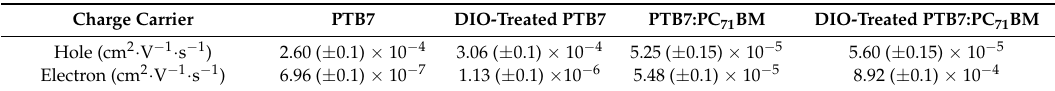
Table 3. The averaged mobility parameter values ( µ ) of charge in each PTB7-based polymer solar cells base on 24